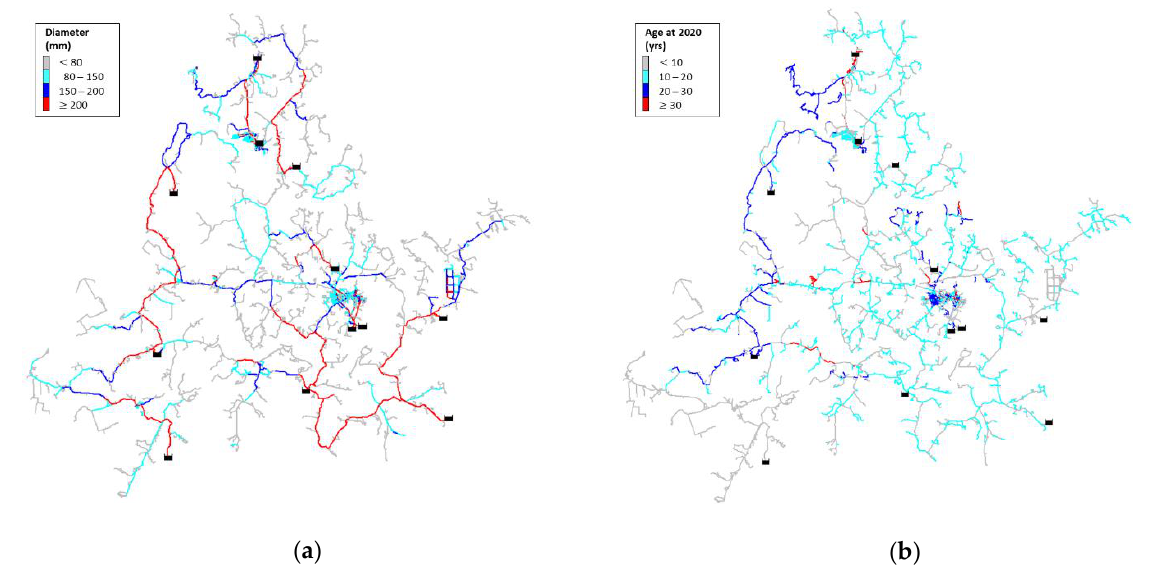
Figure 5. Case study network layout according to ( a ) different pipe diameters and ( b ) different pipe ages.